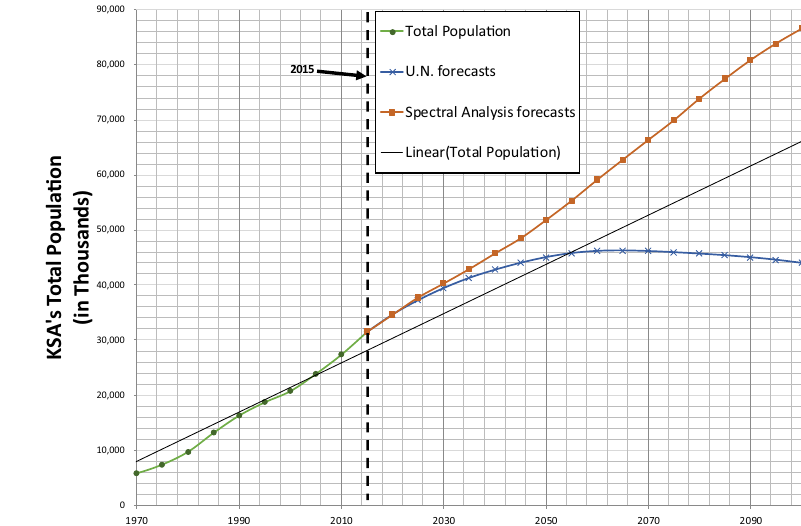
Figure 11. Total population forecasted with spectral analysis versus population projection (medium variant) of the